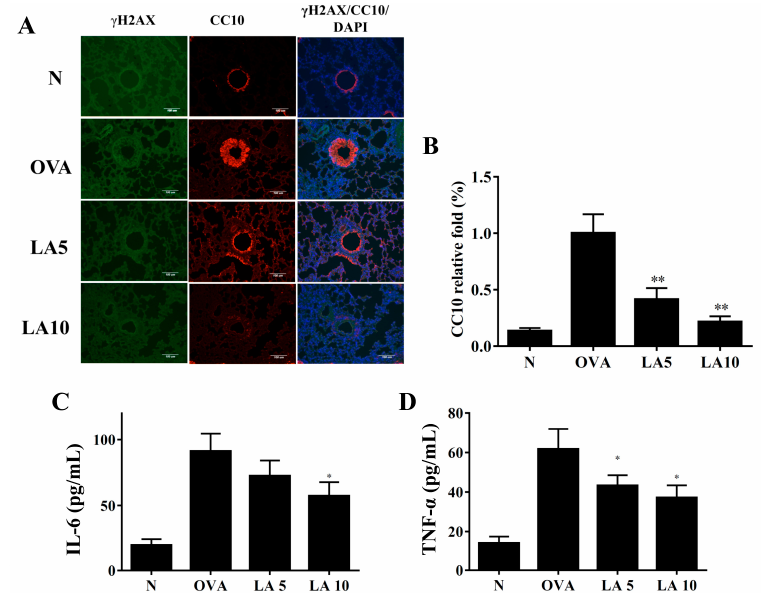
Figure 7. Licochalcone A (LA) affected DNA damage in asthmatic lung tissue. ( A ) Histological sections of lung tissues were stained for γ H2AX (green) and CC10 (red) by immunofluorescence. Nuclei were stained with DAPI (blue) and observed by fluorescence microscopy. ( B ) Fold-changes in the expression levels of CC10 were measured and compared to the OVA group. Effects of LA on the levels of proinflammatory cytokines in BALF. ( C ) The concentrations of IL-6 and ( D ) TNF- α in BALF were measured by ELISA. Three independent experiments were analyzed, and data were presented as mean ± SEM. * P < 0.05 compared to the OVA control group. ** P < 0.01 compared to the OVA control group.